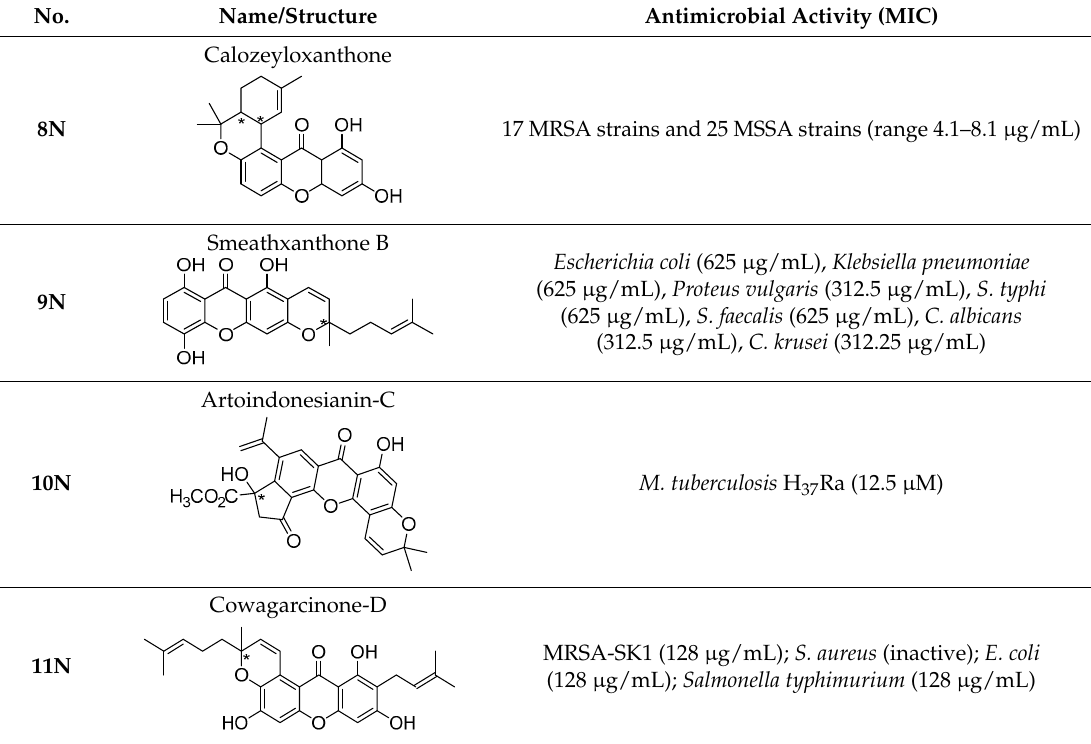
Table 3. Antimicrobial activity of natural CDXs with hydroxy side chains.